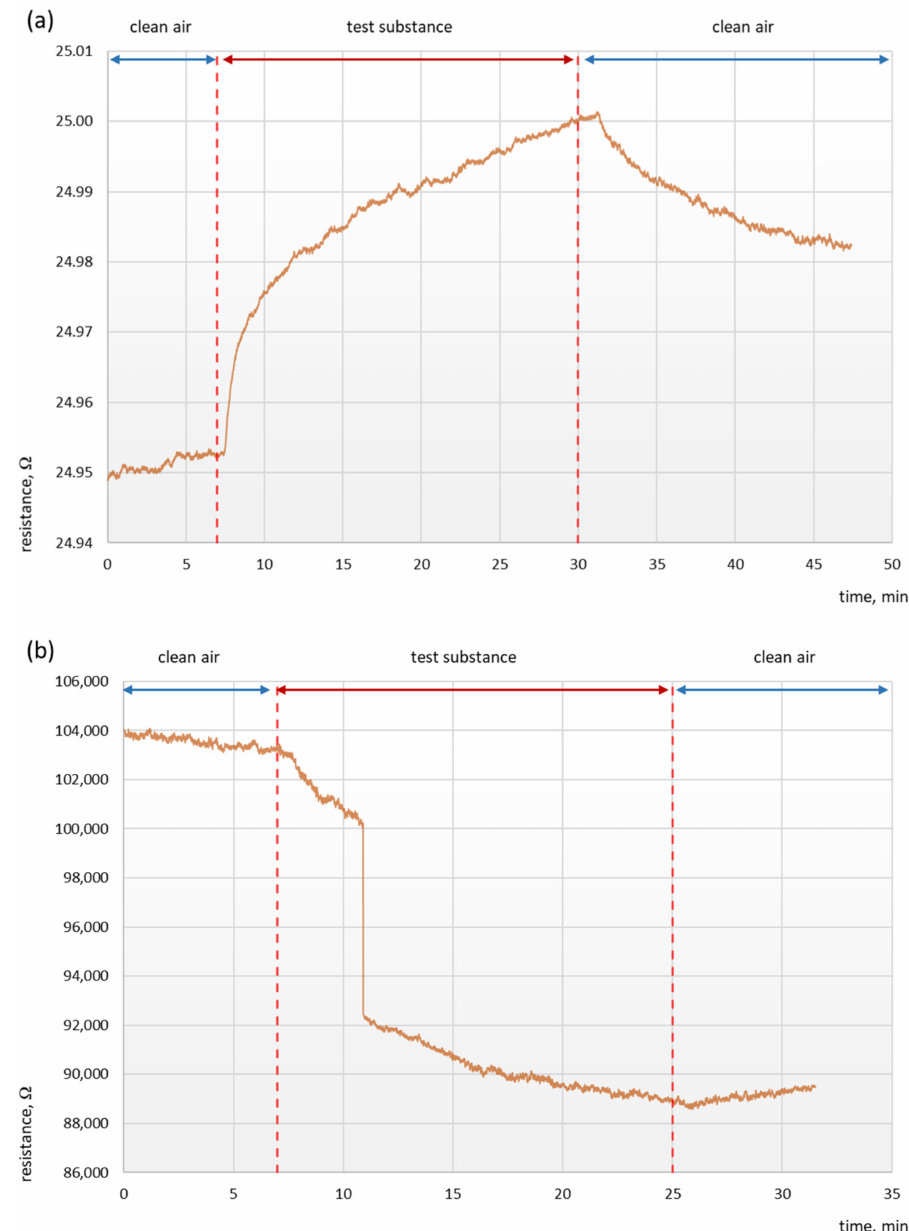
Figure 4. The resistance response of the sensors deposited from: ( a ) D 5 dispersion by spraying and ( b ) D 6 by